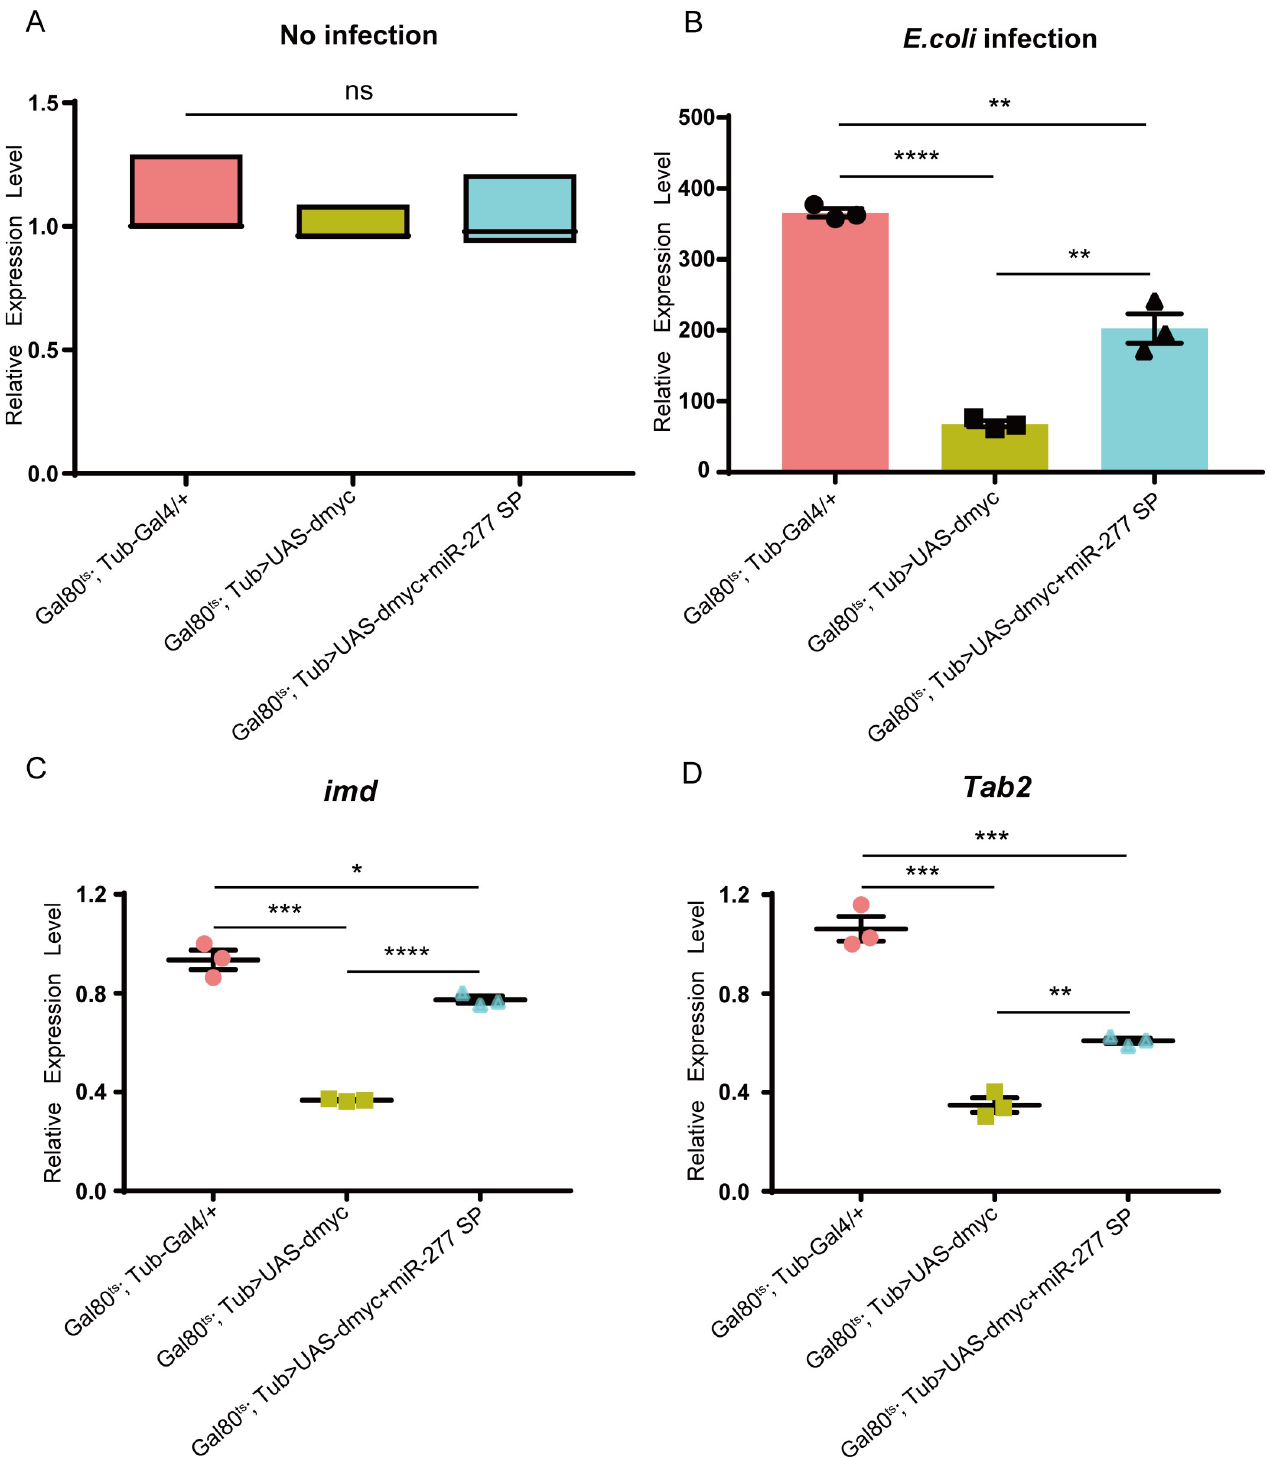
Fig 6. dMyc negatively regulates Drosophila Imd pathway via activating miR-277 to inhibit imd / Tab2 expression. (A) The expression level of Dpt was examined in control flies, dMyc high-expressed flies, dMyc and miR-277 sponge co-highexpressed flies ( Gal80 ts ; Tub > UAS-dmyc+miR-277 SP ) before E . coli infection, respectively. The expression levels of Dpt (B), imd (C) and Tab2 (D) were detected and compared in dMyc highexpressed flies and dMyc and miR- 277 co-highexpressed flies at 6 h following E . coli infection, respectively.